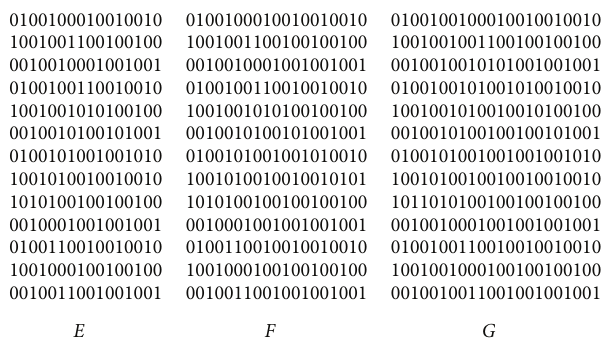
Figure 6: 𝐴𝐸 : dominating set of 𝐶 13 ◻𝐶 42 ; 𝐴𝐹 : dominating set of ◻𝐶 𝐴𝐺 : dominating set of 𝐶 𝐶 13 45 ;